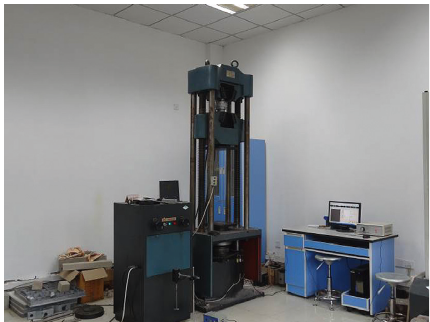
21.5 ° , (b) β 22.5 ° , (c) β 24.5 ° , and (d) β (cid:30) (cid:30) (cid:30)